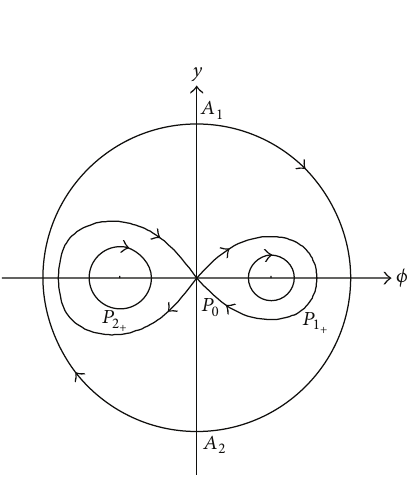
Figure 13: ( 𝛽 > 0 , 𝑎 < 0 , 𝑏 > 0 , 𝑐 > 0